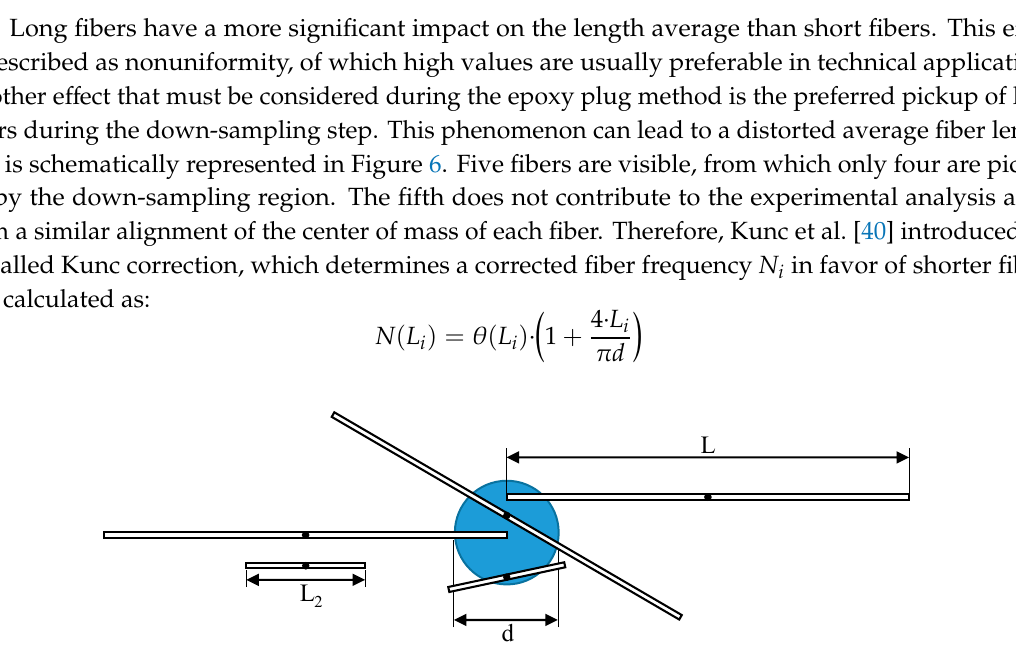
Figure 6. Illustration of the Kunc correction procedure, adapted after [40].